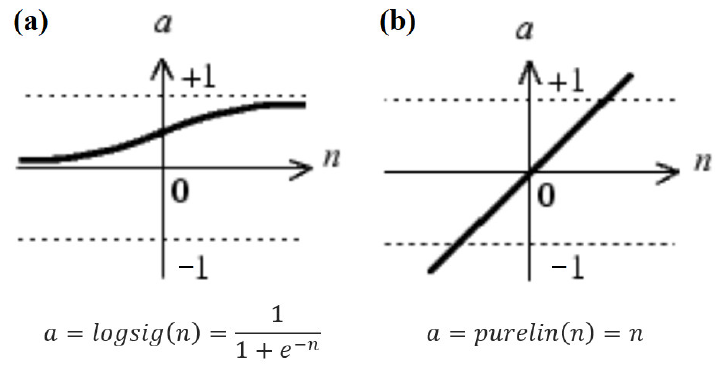
Figure 14. Activation functions: ( a ) logsigmoid; ( b ) purelin.